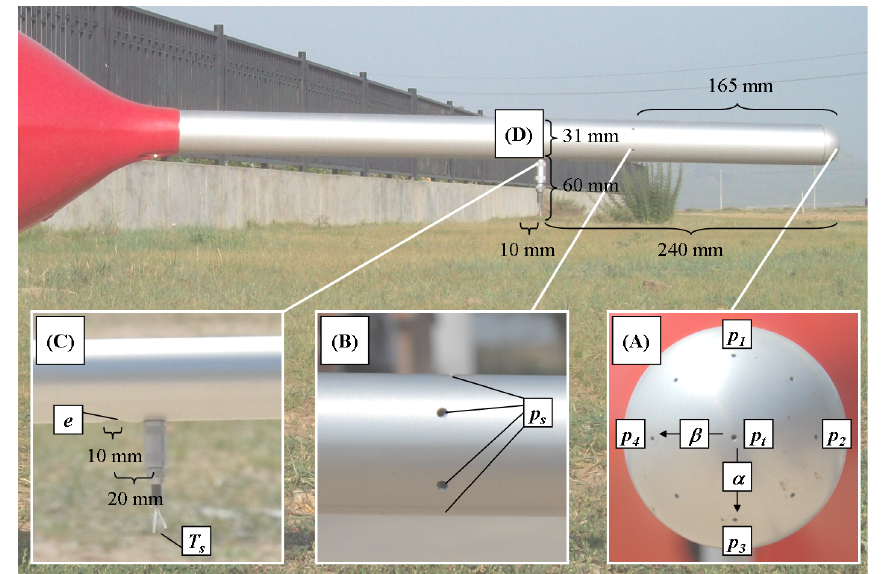
Fig. 3. Layout of the five hole probe, with letters indicating sensor locations. (A) The half sphere tip of the five hole probe, with ports for total- and differential pressure measurements. (B) Ports for static pressure measurement downstream of the half sphere. (C) Thermocouple and port for the capacitive humidity measurement. (D) Location of five hole probe 3-D acceleration sensor. Additional information is given in Sect. 2.2.